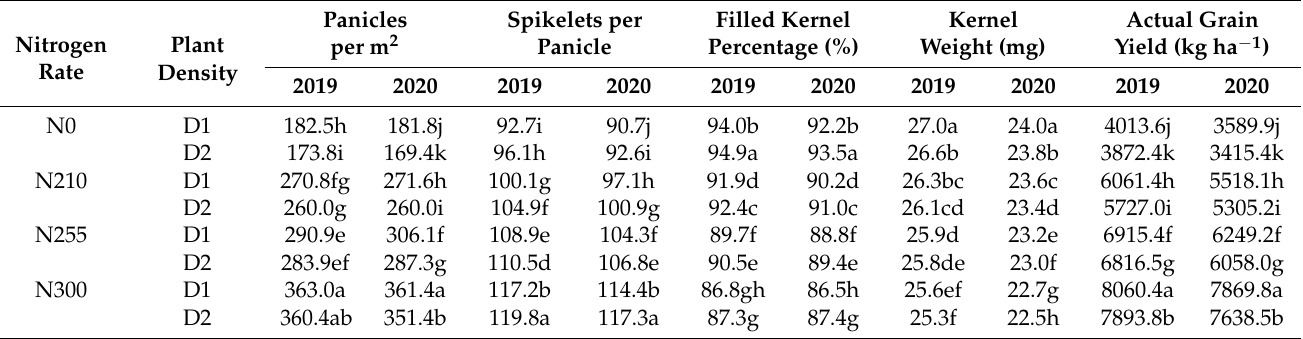
Table 1. Rice grain yield and its components under combined nitrogen rate and planting density in saline